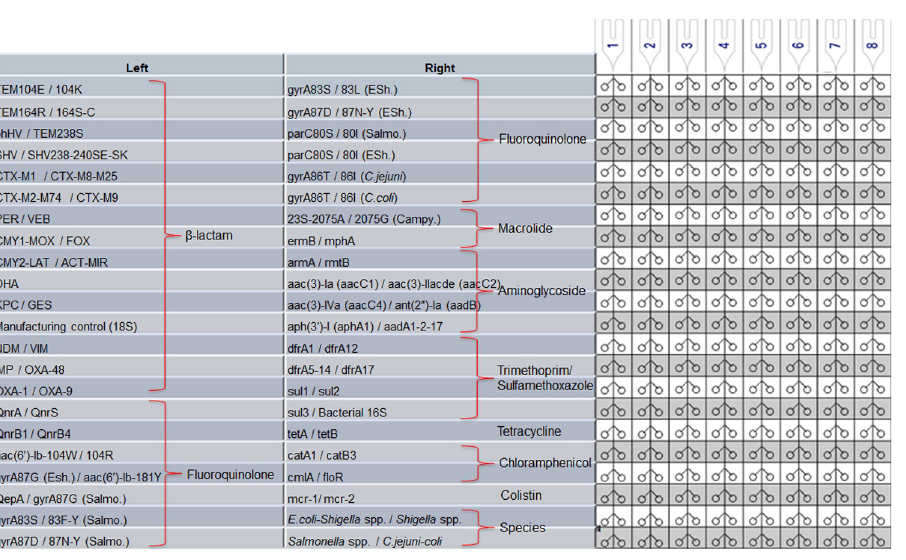
Fig 1. Antimicrobial resistance TaqMan array card (AMR-TAC) layout. The TaqMan array card includes 8 sample ports. Each well was configured and grouped according to antimicrobial resistance associated with those gene targets. Two wells were used for bacterial species/genera detection. The symbol “/” indicates a duplex assay. Because we amplified 42 duplex, 1 singleplex (DHA), and 1 singleplex manufacturing control target, only 44 wells were used out of the 48 well TAC